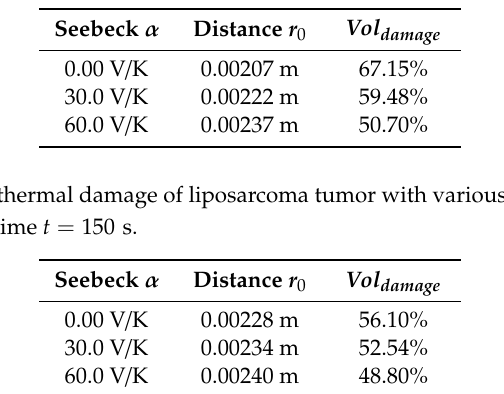
Table8. TheirreversiblethermaldamageofmyxoidliposarcomatumorwithvariousSeebeckcoe ffi cients and at voltage V = 34V and time t = 120 s.